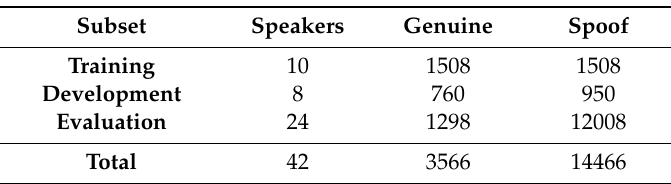
Table 1. The detailed information of the ASVspoof 2017 Version 2.0 dataset. The number represents the quantity of utterances in each